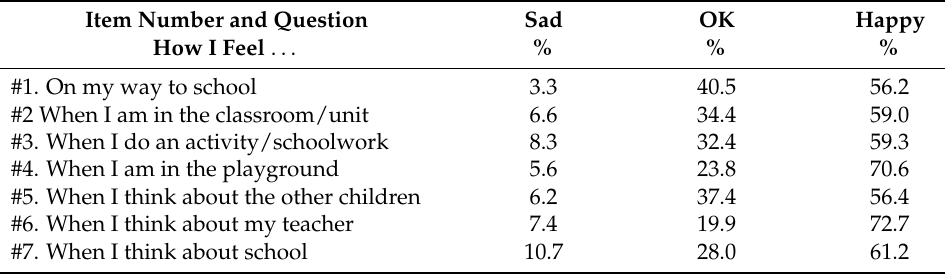
Table 2. Item responses by item on the Swedish version of the